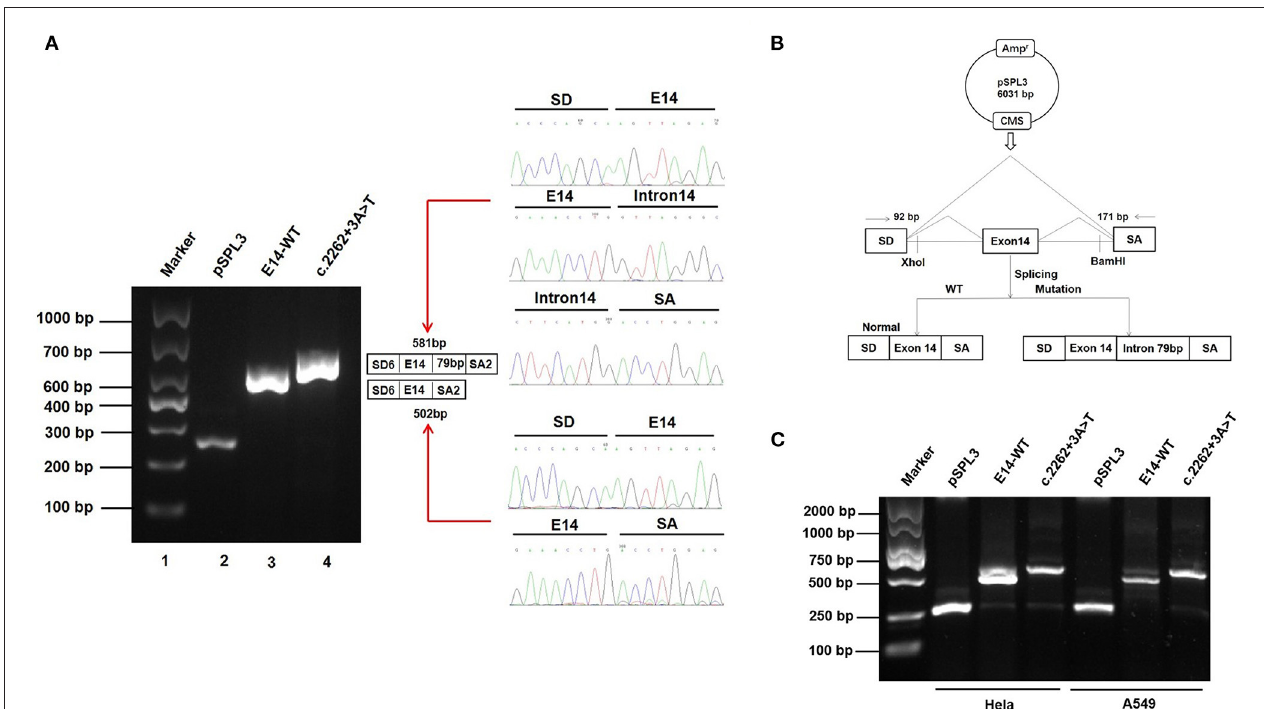
FIGURE 3 | Effect of SCN5A gene c.2262 + 3A > T variant determined by minigene assays. (A) Gel electrophoresis of the RT-PCR products of minigene transcripts in HEK293 cells. Lane 1: marker; Lane 2: pSPL3 (263 bp); Lane 3: E14-WT (581 bp); Lane 4: c.2262 + 3A > T (502 bp). The two fragments were directly sequenced (right). (B) The transcripts produced by the hybrid minigene are shown schematically. (C) Gel electrophoresis of the RT-PCR products of minigene transcripts in HeLa and A549